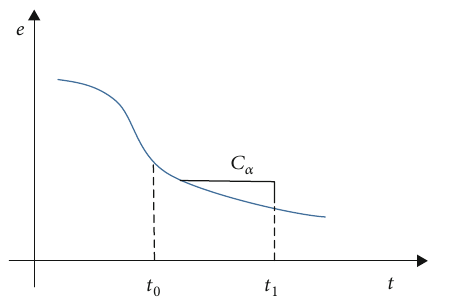
Figure 1: Primary consolidation and secondary consolidation of normally consolidated